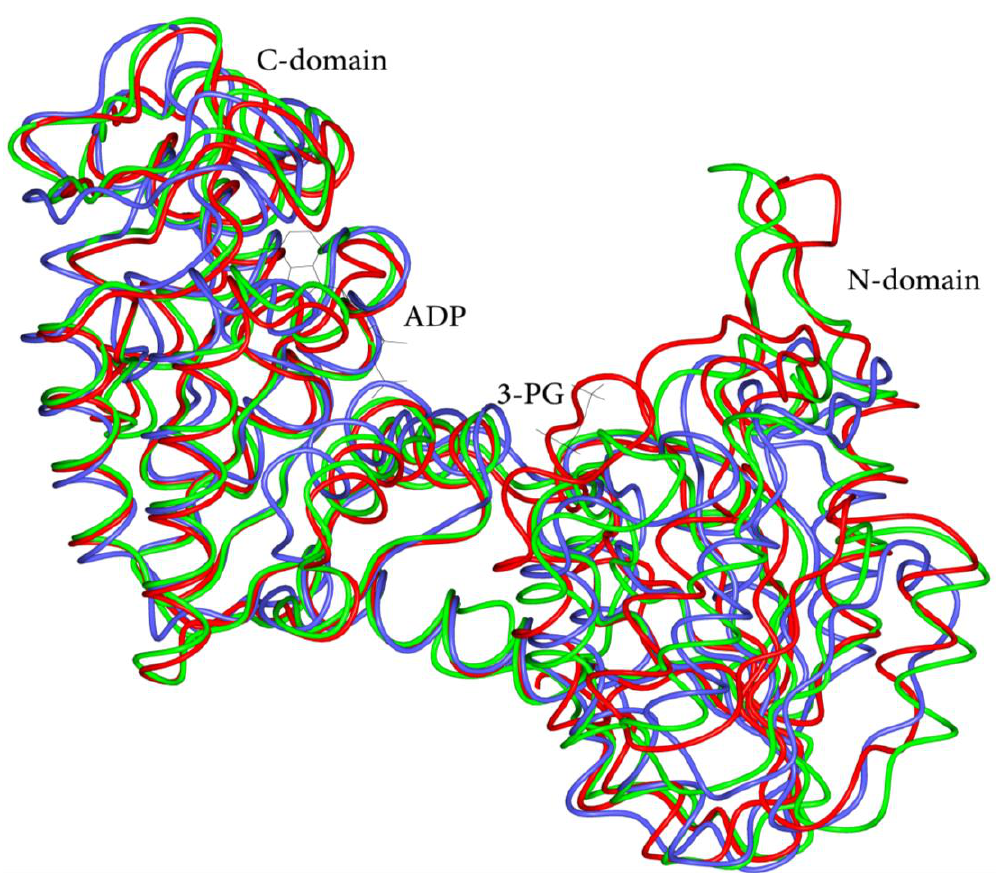
Figure 1. Superimposition of the C α traces of three PGK structures: Escherichia coli (blue, PDB ID 1ZMR), Saccharomyces cerevisiae (green, PDB ID 1FW8) and Homo sapiens (red, PDB ID 2XE7). The conformation of each individual domain, except for a few source-specific insertions, is similar in all structures. Both inter-domain helix and L hinge are almost completely superposed in all the three PGKs, pointing to a conservative evolution of the structural elements and underlining their essential role in the protein function. The bound ligands are shown as thin stick